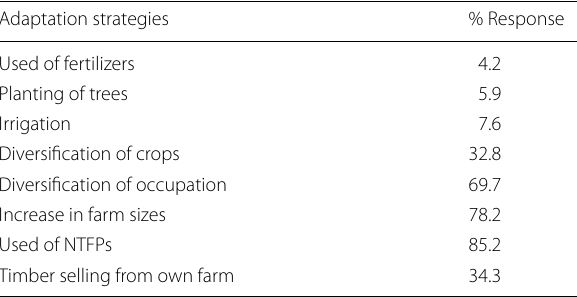
Table 7 Responses on various adaptations as coping